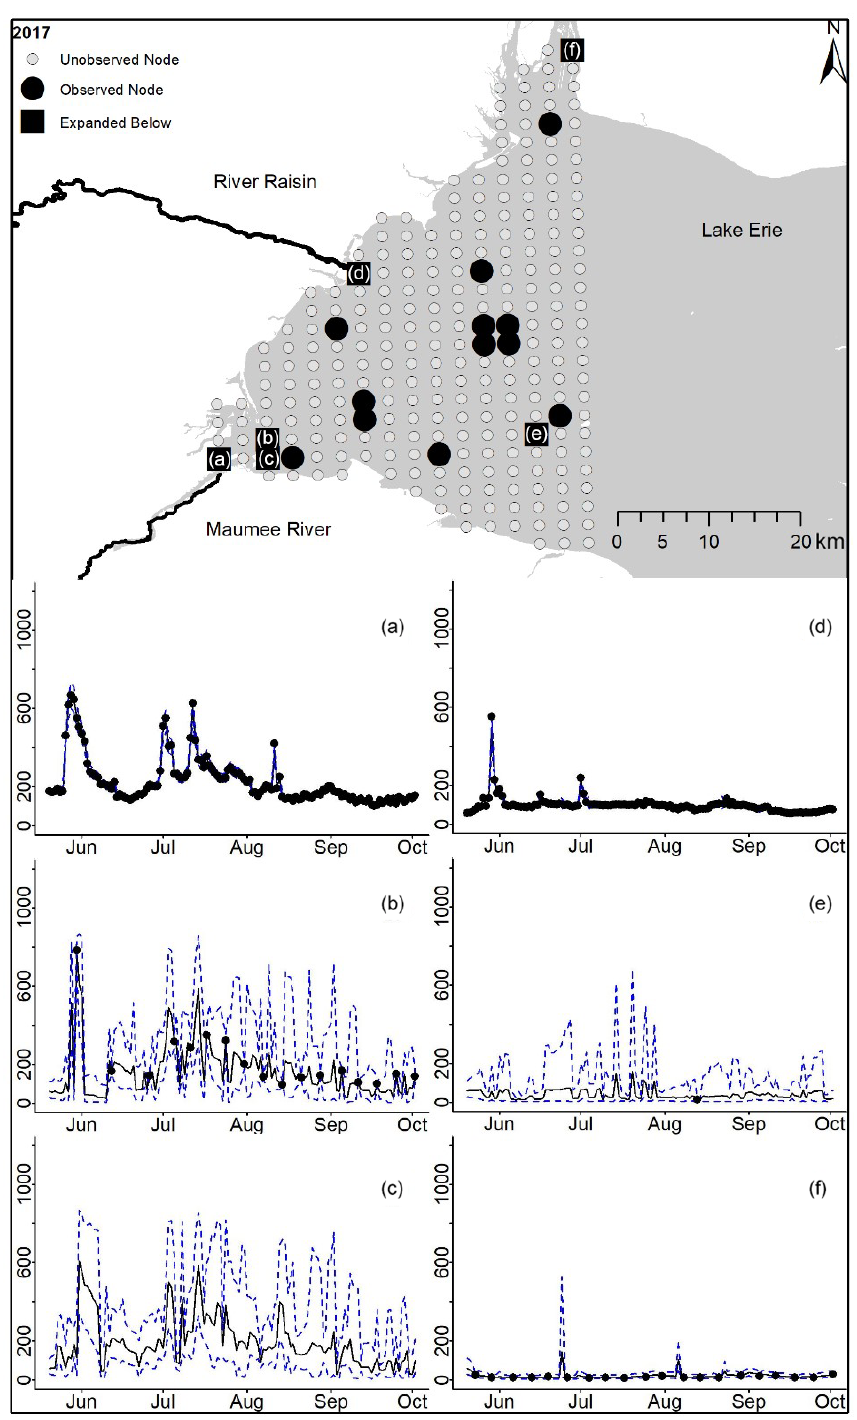
Figure D10. For 2017 the total phosphorus concentrations (µgL − 1 ) at observed and unobserved nodes were estimated from the model posterior samples. Mean (solid black line) and 95%PI (dashed blue line) for the model posterior samples of each node at every day for (a) the Maumee River, (b, c, e, f) western Lake Erie nodes, and (d) the Raisin